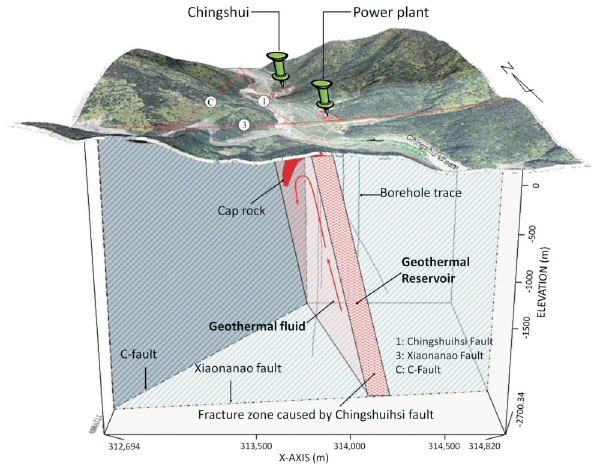
Fig. 2. The cross-sectional map of the inferred hydrologic feature- sof the Chingshui hydrothermal system (Tong et al.,